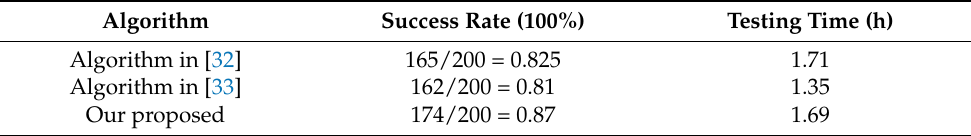
Table 11. Comparison of test results of each algorithm in simulation Figure 6b.